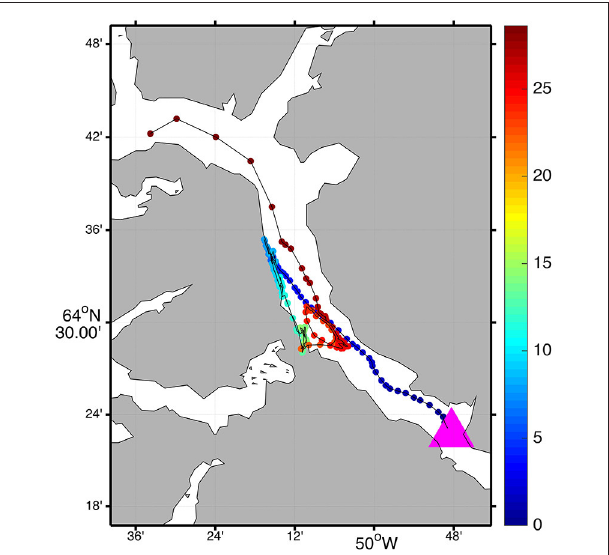
FIGURE 10 | A trajectory of an EXITE beacon initially deployed at the large pink triangle. Locations are color-coded according to time, in days, since deployment. Every 4th measurement is shown for